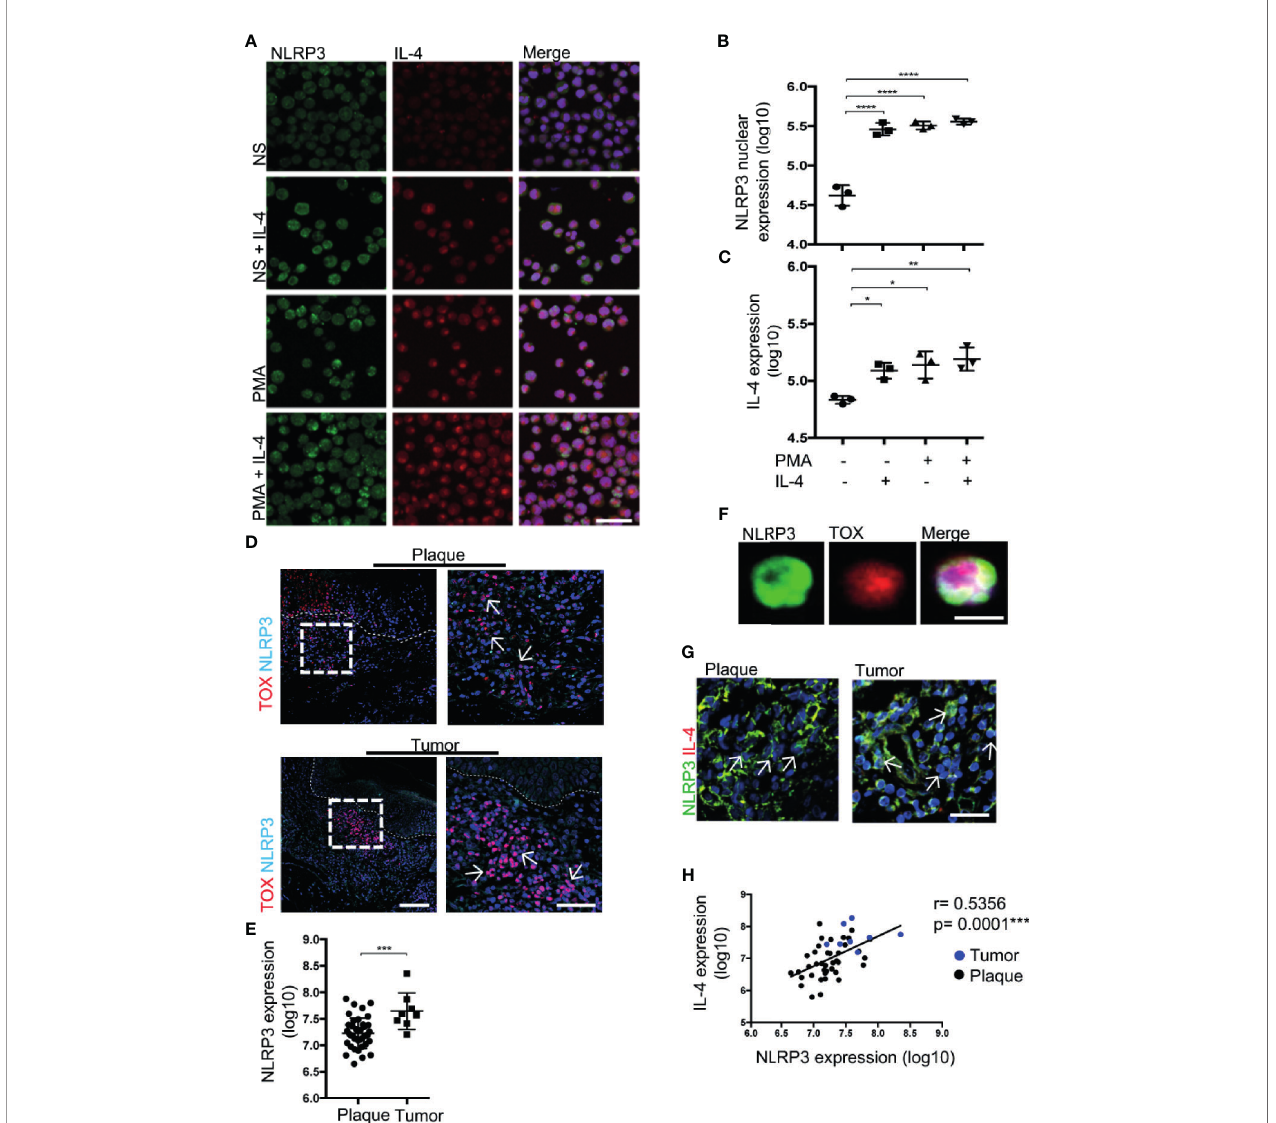
FIGURE 5 | IL-4 promotes NLRP3 nuclear localization in malignant CD4 + T cells, and tumor lesions show augmented NLRP3 expression in CTCL. (A) HTB-176 cells stimulated with PMA/ionomycin and recombinant IL-4. Representative immuno fl uorescence (IF) of NLRP3 (AF-488) and IL-4 (AF-594). Quanti fi cation of (B) NLRP3 nuclear expression and (C) total expression of IL-4 in the microphotographs of the different treatments (n = 3). (D) Representative IF for the coexpression of TOX (AF-594) and NLRP3 (AF-647) in CTCL plaques and tumors. Quanti fi cation of the total expression of (E) NLRP3 in the microphotographs of the plaques (n = 39) and tumors (n = 8). (F) Representative IF of NLRP3 (AF-488) and TOX (AF-594) expression in CD4 + T cells isolated from the skin of CTCL tumors (n = 3). (G) Representative IF for NLRP3 (AF-488) and IL-4 (AF-594) expression in plaques and tumors. (H) Correlation between NLRP3 and IL-4 expression from (G) (black dot: plaque; blue dot: tumor). The dotted line indicates the dermoepidermal junction. Arrows indicate the coexpression of markers in the different staining. Error bars = SEM. *P < 0.05; **P < 0.005; ***P < 0.001; ****P < 0.0001. Scale bars= 20